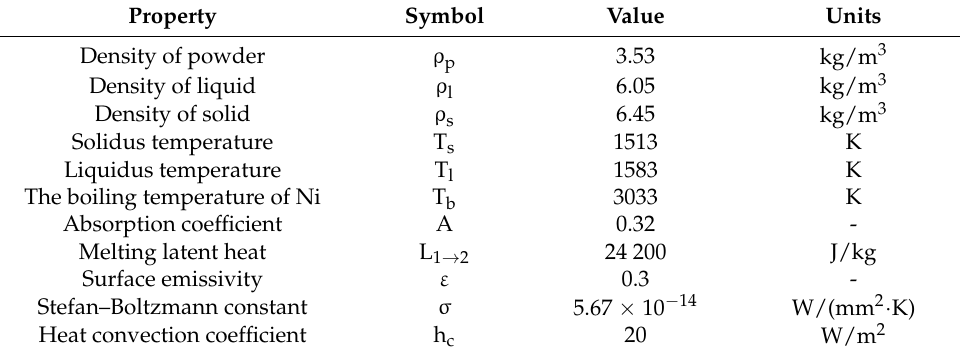
Table 3. Thermal physical properties utilized in the FE model